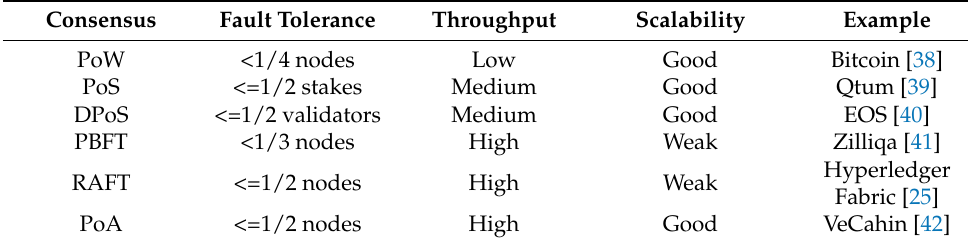
Table 2. Comparison of consensus mechanisms